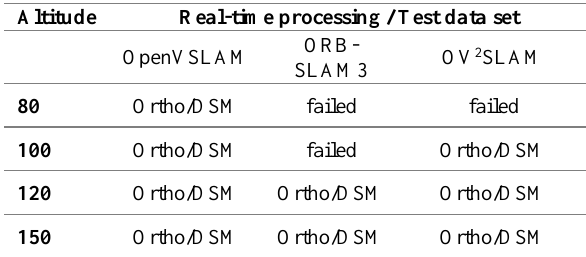
Table 2 Generated data products in OpenREALM